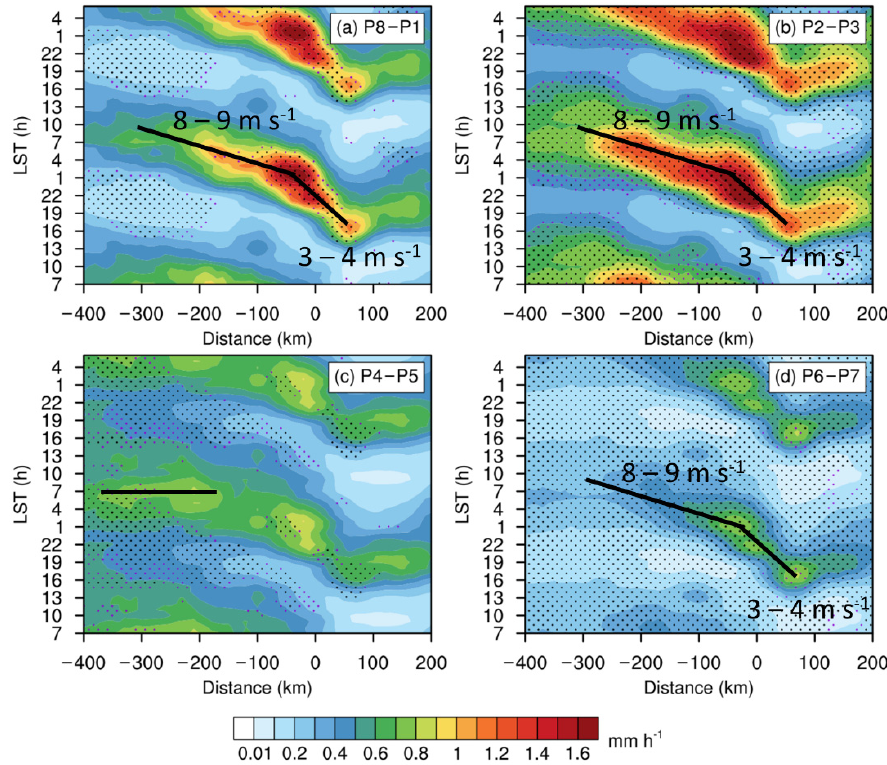
Figure 3. The time-distance Hovmöller diagrams of hourly precipitation rate (mm h − 1 ) in ( a ) P8–P1, ( b ) P2–P3, ( c ) P4–P5 and ( d ) P6–P7 averaged in DJF 2011–2020. The purple and black dots indicate the 90% and 95% confidence according to the Student’s t-test.